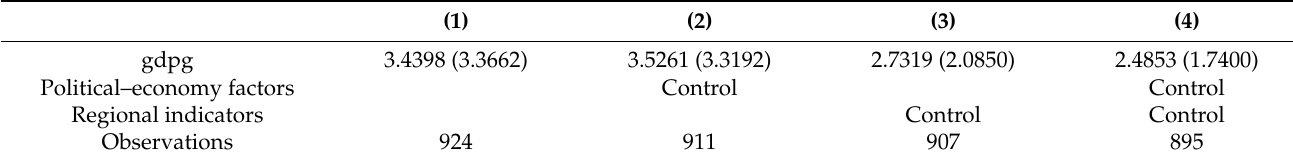
Table 4. Relationship between establishment time and economic growth before establishment.